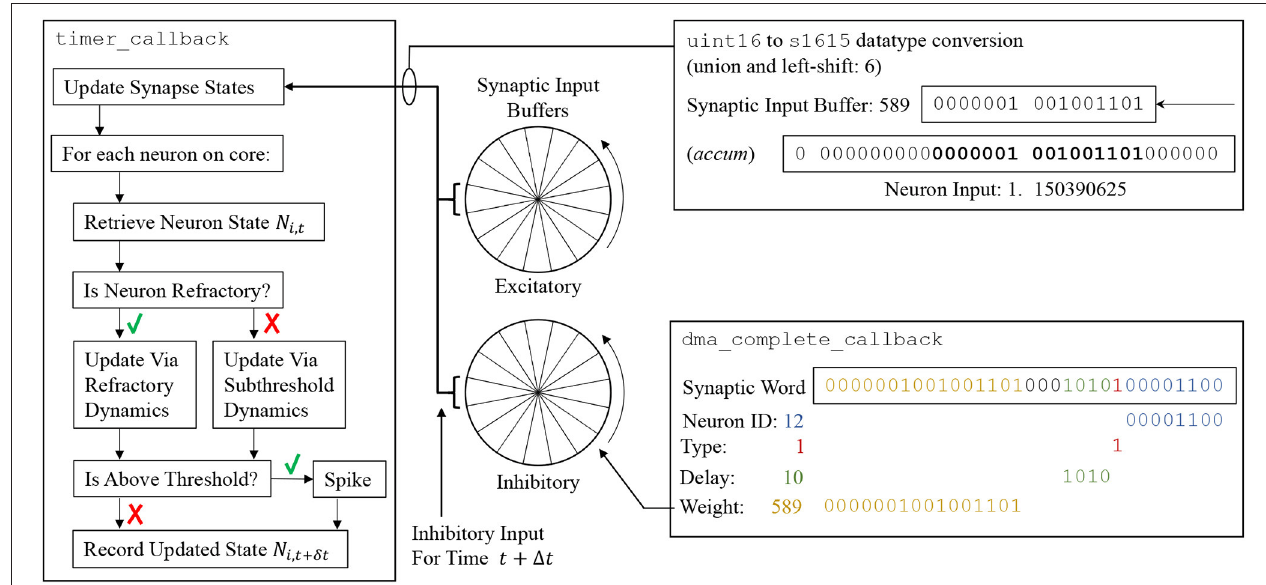
FIGURE 6 | (Left) Update flow advancing state of neuron N i by 1 t . (Center) Circular synaptic input buffers accumulate scaled input at different locations based on synaptic delay (buffers are rotated one slot at the end of every timestep). (Right top) Synaptic input buffer values are converted to fixed-point format and scaled before adding to N i . (Right bottom) Decoding of synaptic word into circular synaptic buffer